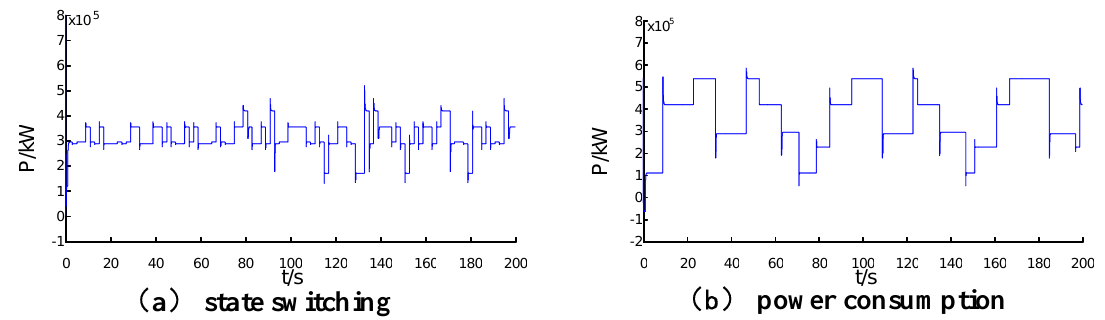
Figure 10. The comparison of the ADN Feeder Power in underpowered condition; ( a ) state switching; ( b ) power consumption.